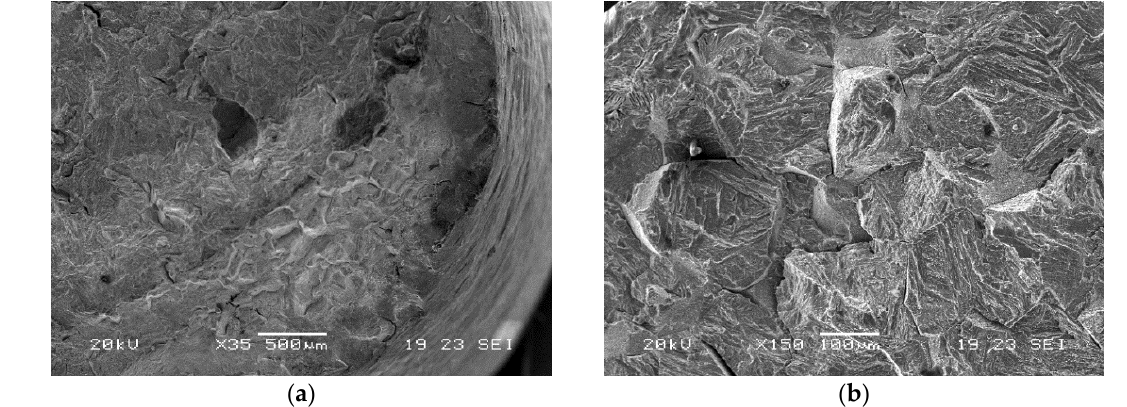
Figure 9. SEM images of fracture surfaces of a group X sample after SSRT test of immersion in NACE A solution ( a ) edge, ( b ) core. Materials 2020 , 13 , x FOR PEER REVIEW